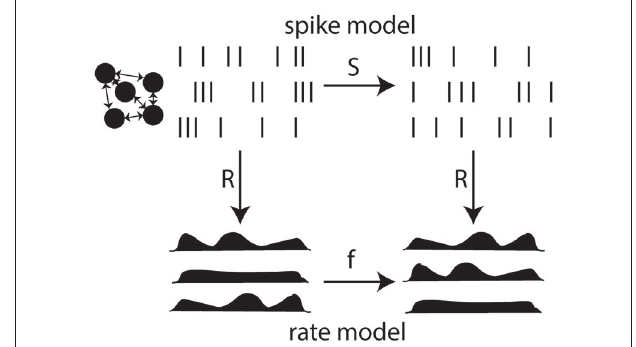
FIGURE 6 | Reduction of a spike-based model to a rate-based model . The spike model defines a relationship between presynaptic and postsynaptic spike trains through a function S. The rate model defines a relationship between rates through a function f. Rates are related to spikes through an observation function R. Reduction is possible when the diagram commutes: the composition of R and S equals the composition of f and R (mathematically, R o S = f o R). This is not generally possible because R is not invertible (many spike trains have the same